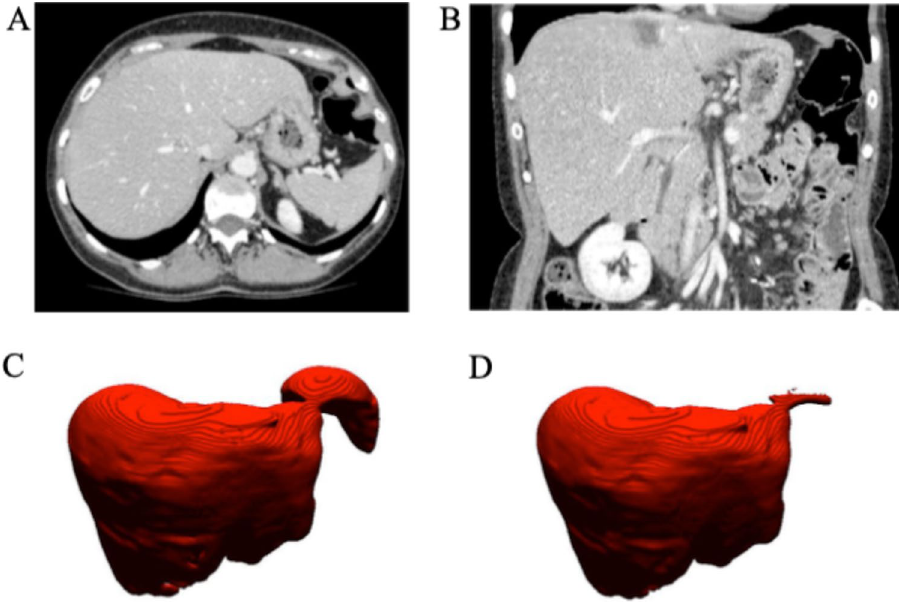
Figure 4. Example of PADLLS oversegmentation correction of the spleen and stomach. Axial ( A ) and coronal ( B ) CT slices of the segmented dataset at the level of the liver. ( C ) H-DenseUnet segmentation of liver from 3DIRCADb dataset that includes the spleen. ( D ) Final pipeline segmentation that accurately captures the lateral margin of the liver adjacent to the stomach but does not oversegment with the stomach or spleen. WW and WL of 350 and 40 HU were used, respectively.